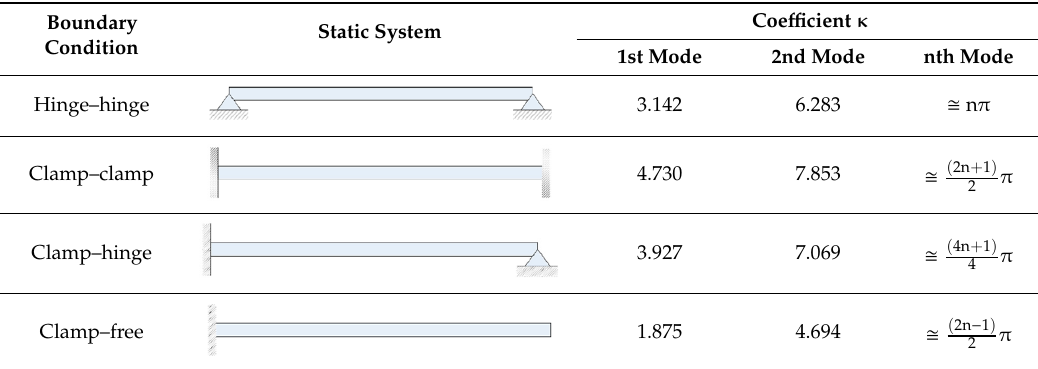
Table 1. Value of boundary condition parameter κ for the first two [19] and nth [20] natural frequencies having various boundary conditions.